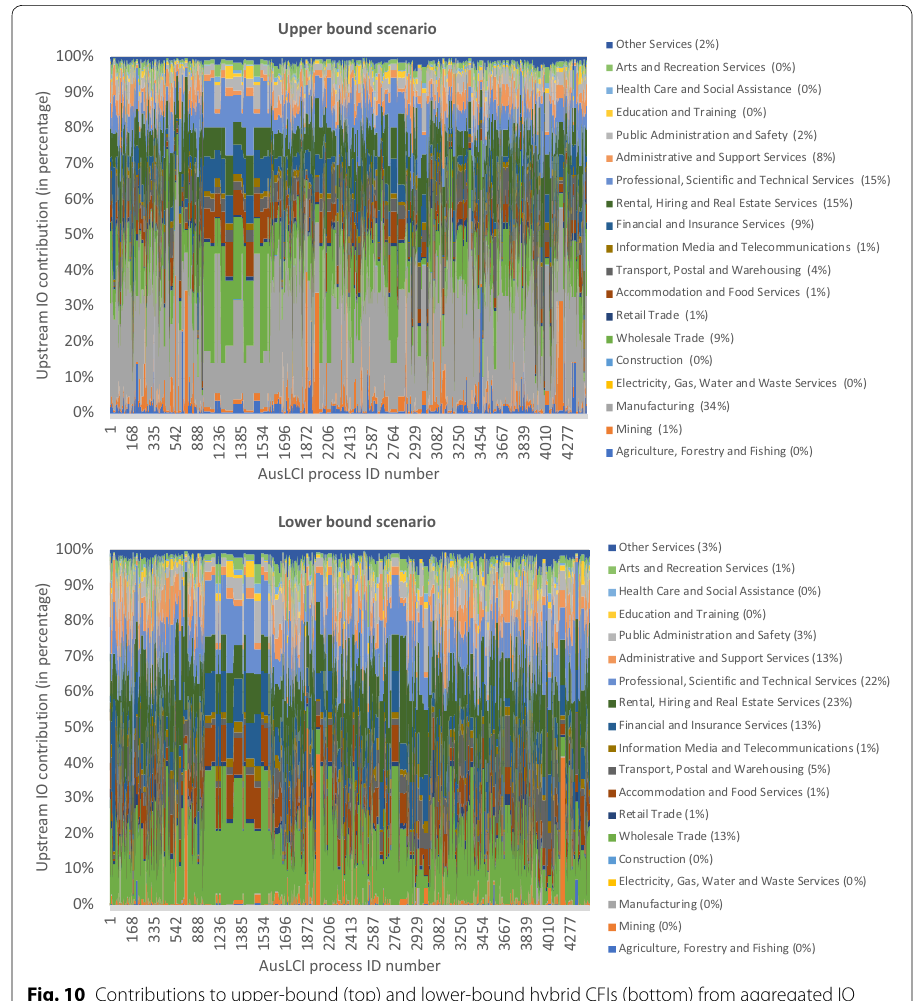
Fig. 10 Contributions to upper-bound (top) and lower-bound hybrid CFIs (bottom) from aggregated IO industries, in relative terms. The relative contribution from a broad industry is shown in brackets after its